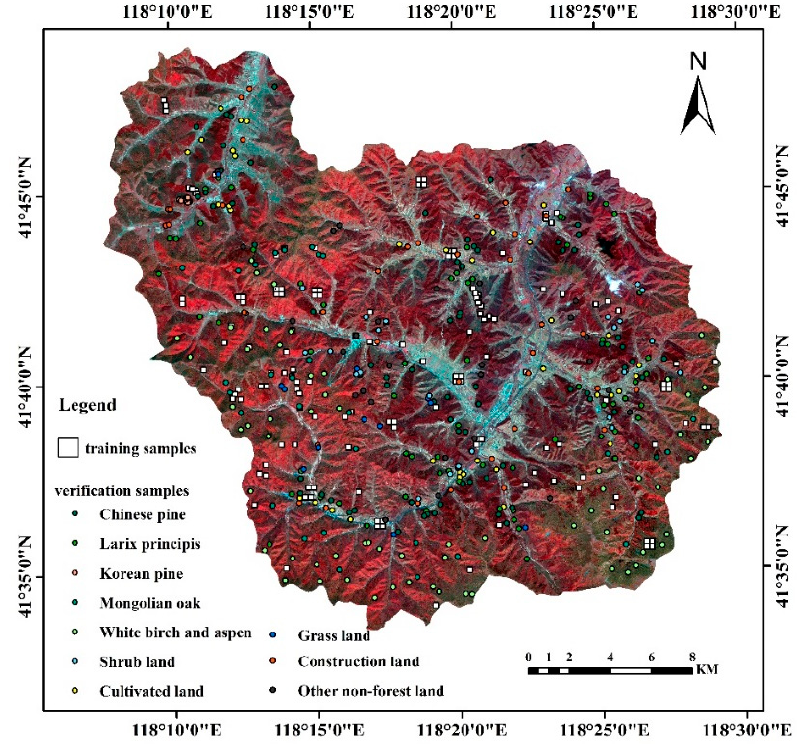
Figure 3. Spatial distribution map of the field survey sample points and some of the training samples